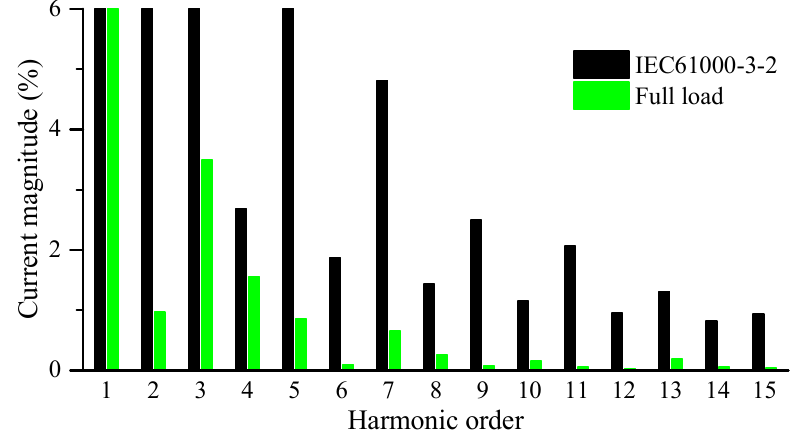
Figure 17. Grid current harmonic orders vs. IEC61000-3-2 (Class-A).